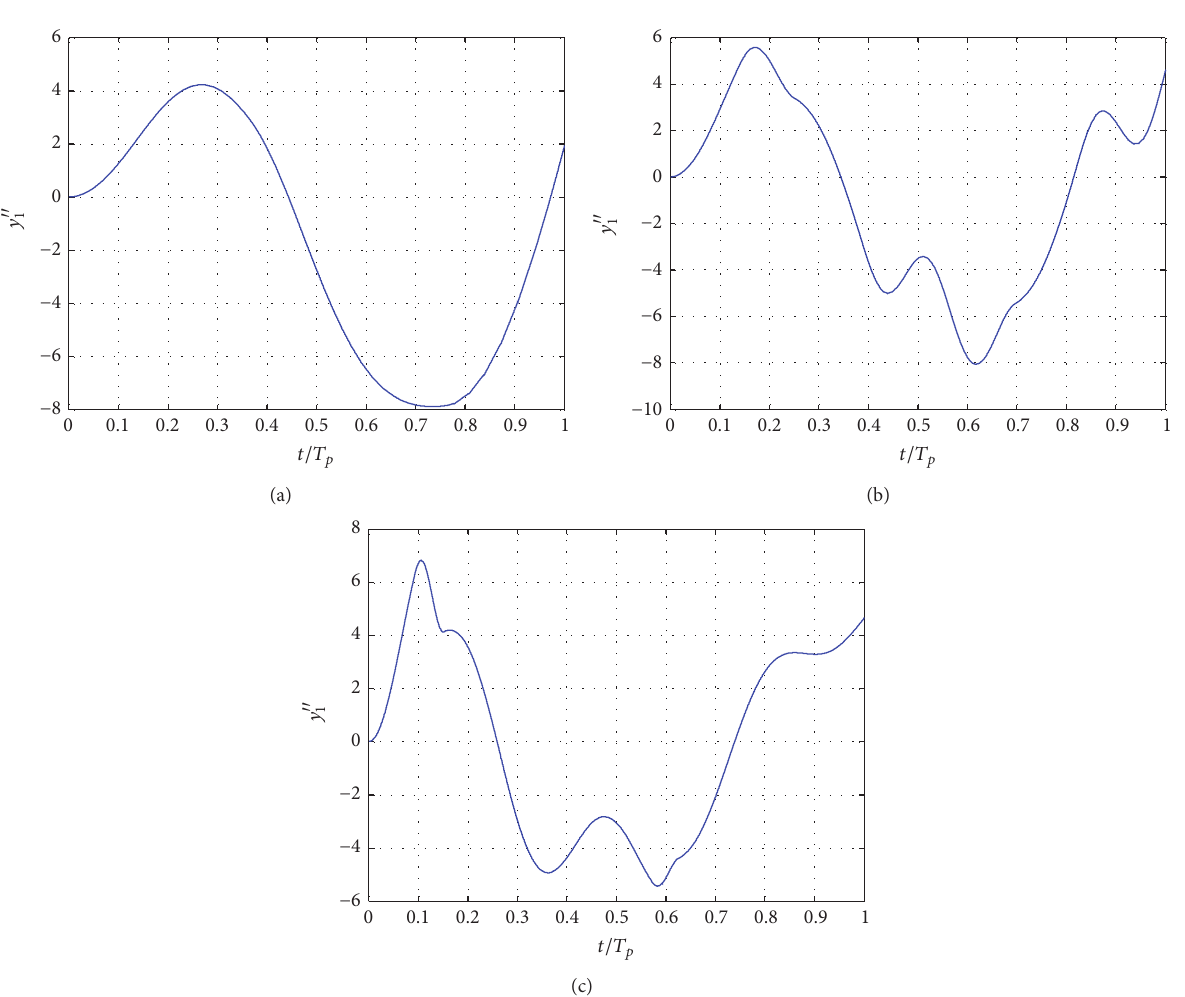
Figure 7: Acceleration response of the primary mass of the two-degree-of-freedom model under a versed sine base input when ̂𝑘 = 0.4 ̂𝐹 = 0.6 . (b) Stiffness ratio ̂𝑘 = 2.5 , ̂𝐹 Stiffness ratio , opt